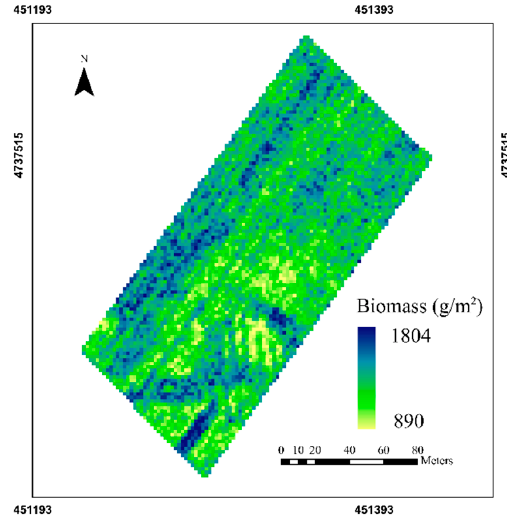
Figure 11. Winter wheat final dry aboveground biomass map derived from UAV-based LAIe maps and the SAFY model.